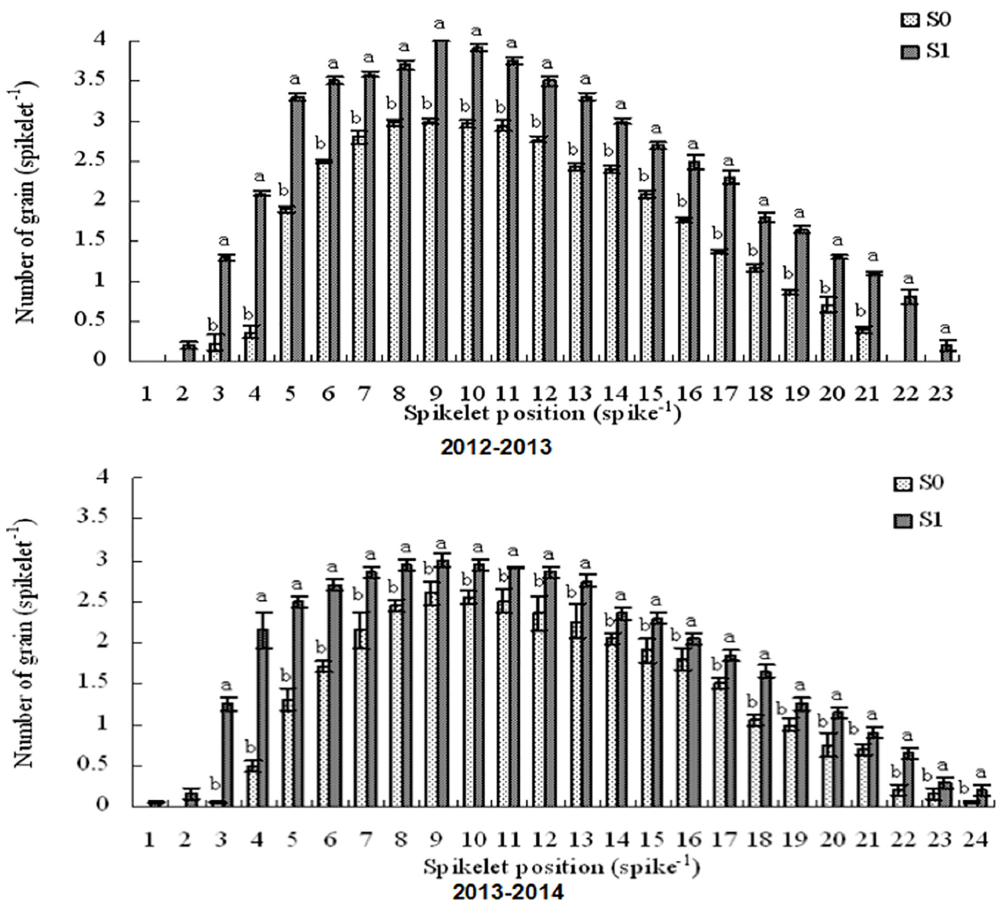
Fig 6. Number of grains at each spikelet position after the two foliar spray treatments (S0: water [pale grey bars]; S1: 6-BA [dark grey bars]). The data are presented as the treatment mean ± standard error, n = 3. The different letters indicate significant differences (P < 0.05) at each spikelet